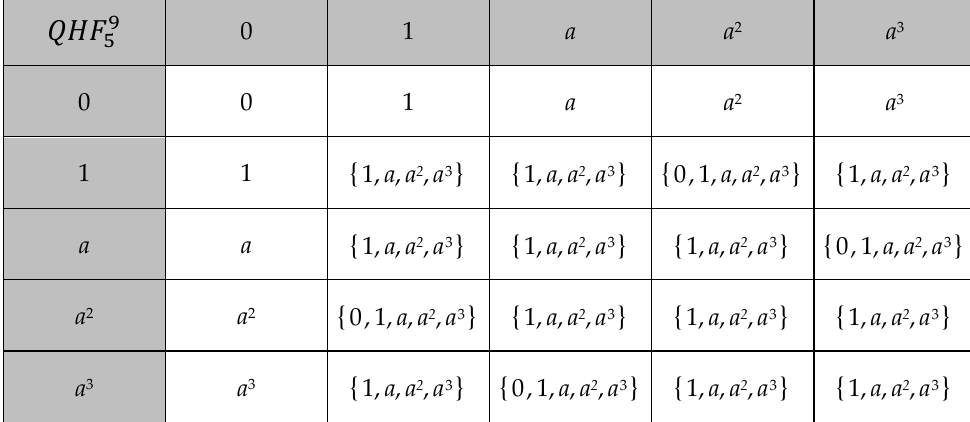
Table 21. The Cayley table of the additive canonical hypergroup of the quotient hyperfield